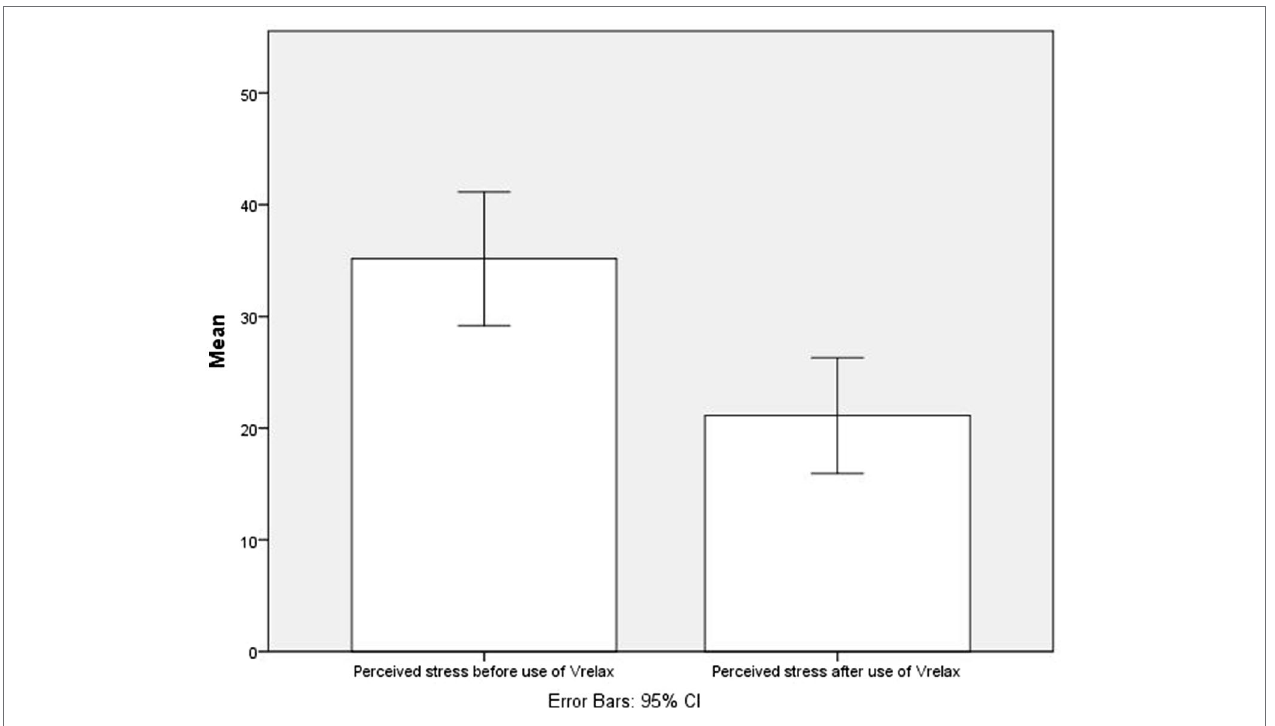
FIGURE 1 | Perceived stress before and after use of